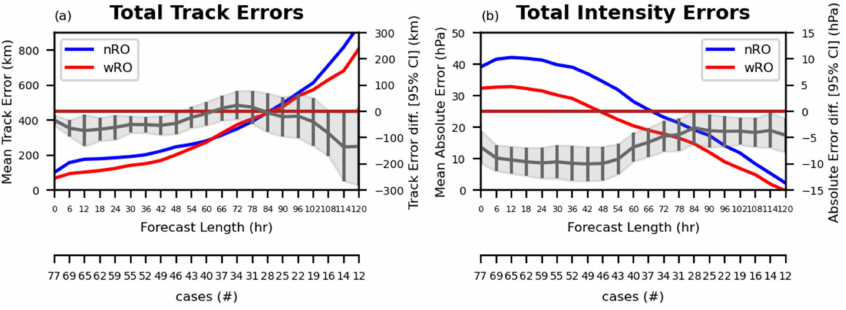
Figure 10. ( a ) Average typhoon track errors and ( b ) intensity errors for four typhoons, namely, Bavi, Maysak, Haishen, and Hagibis. The nRO and wRO are shown in blue and red, respectively, and their differences with 95% confidence intervals are shown in gray. The numbers of forecast cases are printed at the lowest